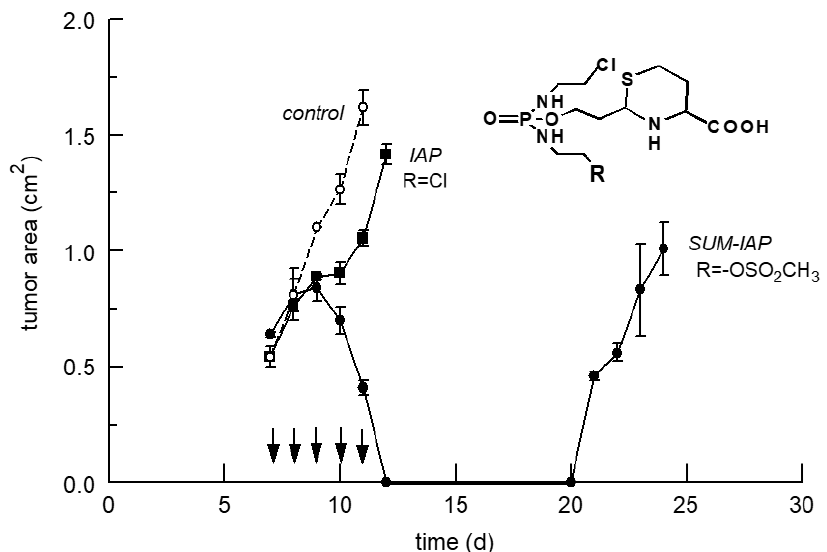
Figure 6. Tumor growth curves of subcutaneously transplanted P388 tumors in female CD2F1 mice following therapy with 0.29 mmol IAP (115 mg/kg) ( ■ ) or SUM- IAP (133 mg/kg) (●) i.p. on day 7–11 (arrows), mean ± standard deviation from 3 animals. “Control” ( ○ ) shows the tumor growth curve of subcutaneously transplanted P388 mice leukemia cells in untreated female CD2F1 mice.